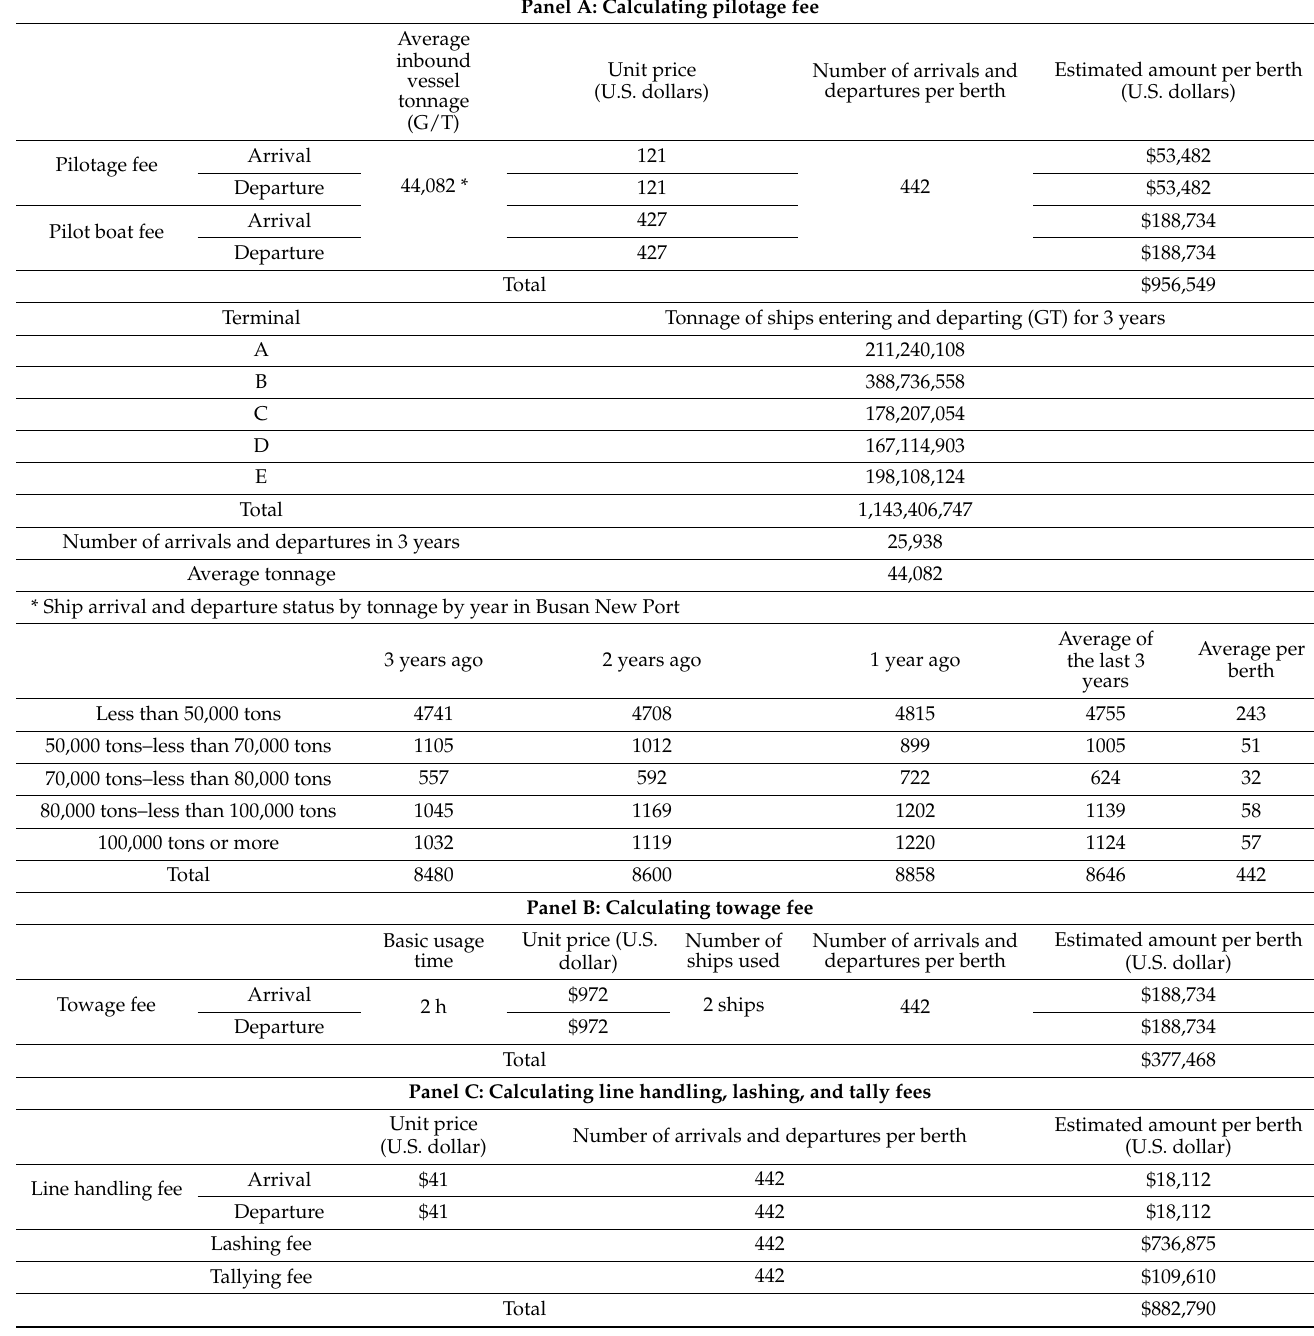
Table 9. Estimating the added value of port services